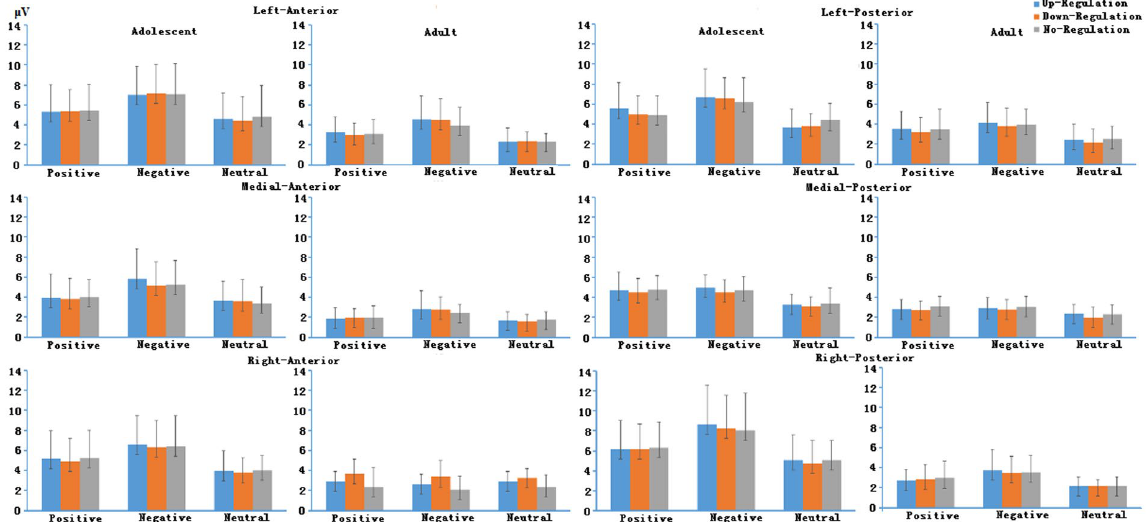
Figure 4. LPP averages in early time windows in different experimental conditions between adolescents and adults.